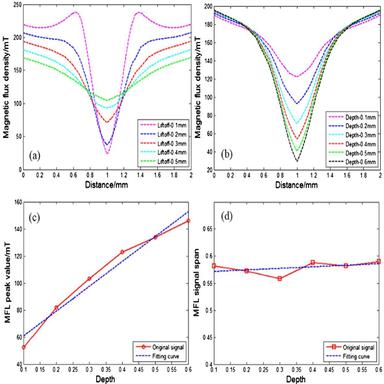
MFL signals and characterizations of trapezoid defect; (a) MFL signals of trapezoid defect in different liftoff values with the depth of 0.3 mm; (b) MFL signals of trapezoid defect in different depths with the liftoff of 0.3 mm; (c) Relationships between MFL peak values in (b) and defect depths; (d) Relationships between MFL signal spans in (b) and defect depths.